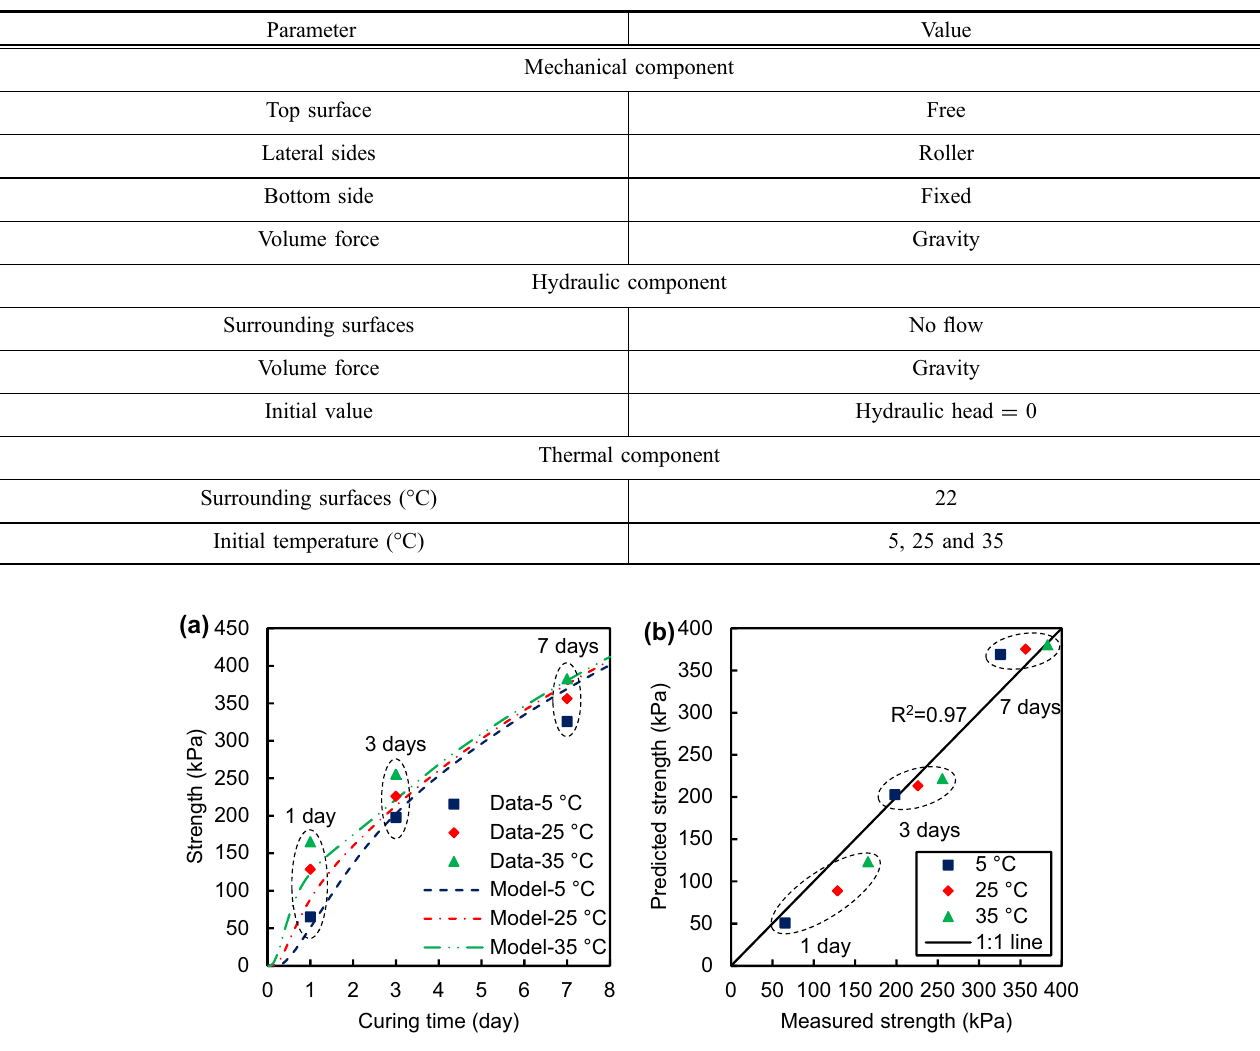
Table 3 Initial values and boundary conditions in Case Study 1.